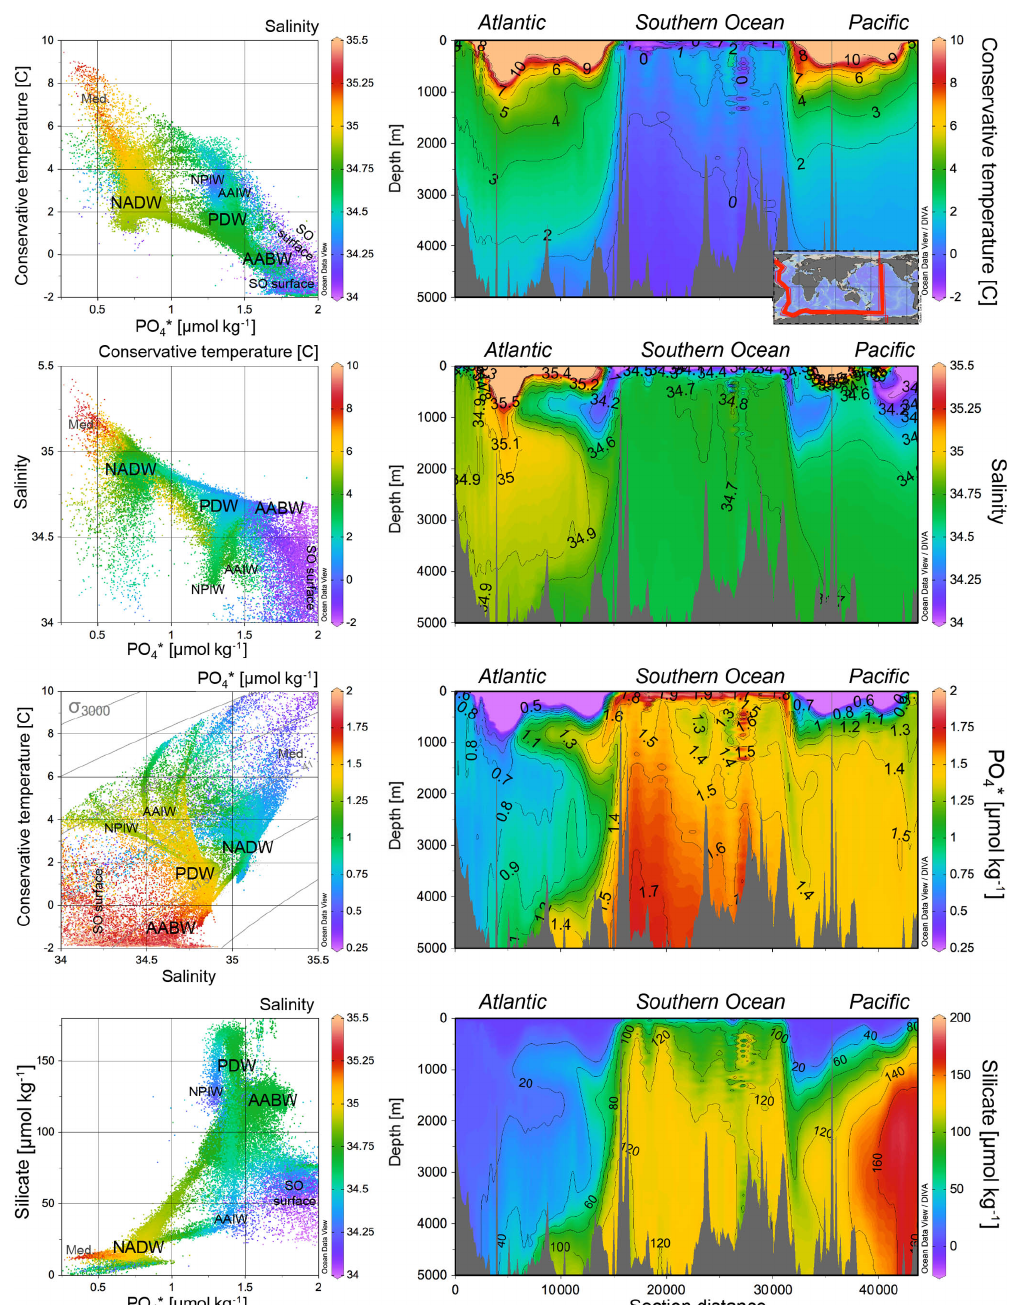
Figure 8. A global hydrographic section for potential temperature, salinity, PO ∗ with neutral density greater than 27.2kgm − 3 ; the colours of the dots refer to the scale shown to the right of the cross plots. Data are from GLODAPv2 (Key et al., 2015; Olsen et al., 2016) with profiles, maps, and sections plotted in ODV (Schlitzer, 2015), with sections contoured using isopycnic